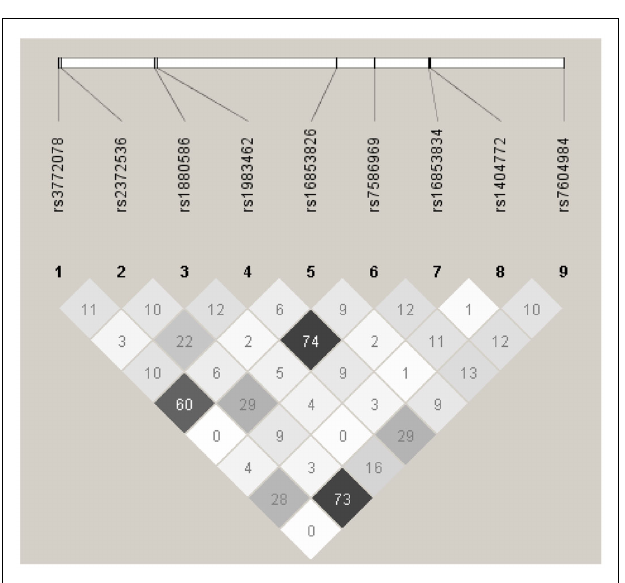
FIGUREA1 | Linkage disequilibrium plot for tagSNPs in AITC using 2,233 Caucasian subjects, Mayo Clinic, and Duke University. Numbers in squares indicate the correlation ( r 2 ) between